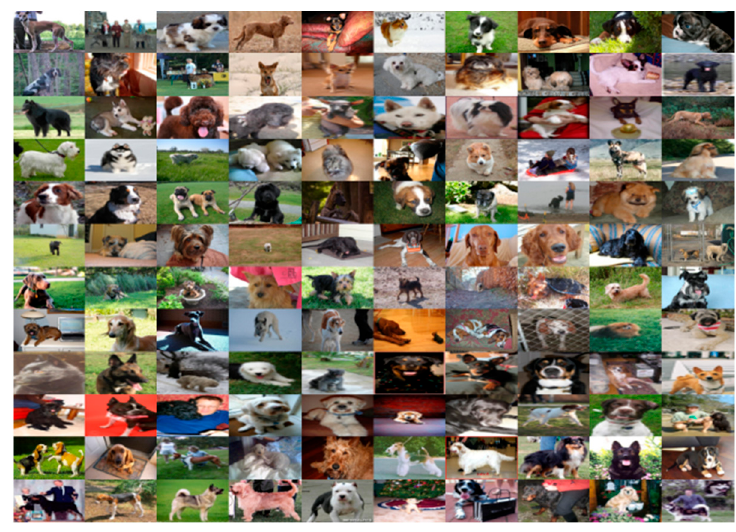
Figure 12. Some images of the TestSet2.